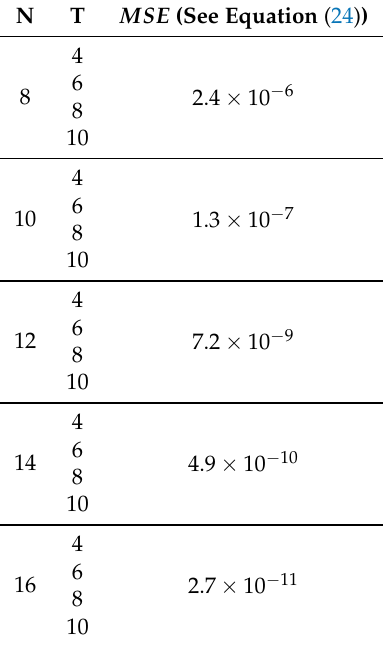
Table 5. Mean square error (MSE) between the Fuzzy Matlab Toolbox and the proposed hardware implementation for several cases N and T